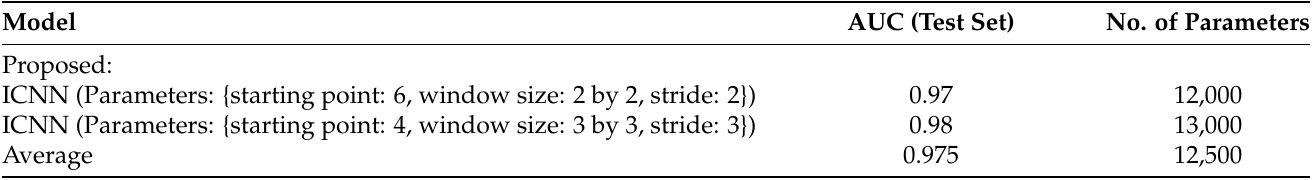
Table 12. Multiclass lung cancer variants diagnosis: the experiment results for multiclass lung cancer variants classification. In total, there are 4 classes (0: healthy, 1: COVID-19, 2: pneumonia, and 3: tuberculosis). The table summarizes the benchmark performance as well as the prediction performance of the proposed method. All results are measured in area under the curve (AUC). Multiclass AUC values are the average of the AUC values from the 4 different classes, which were calculated using a statistical software package named pROC, which requires the same computation of sensitivity and specificity (these definitions are discussed in Equations (19) and (20)). The average prediction performance for 4-class diagnosis is 89% with 26 million parameters in a variety of different neural networks designs. The average prediction performance for 4-class diagnosis is 97.5% with only 13,000 parameters in the proposed network architecture. Model AUC (Test Set) No. of